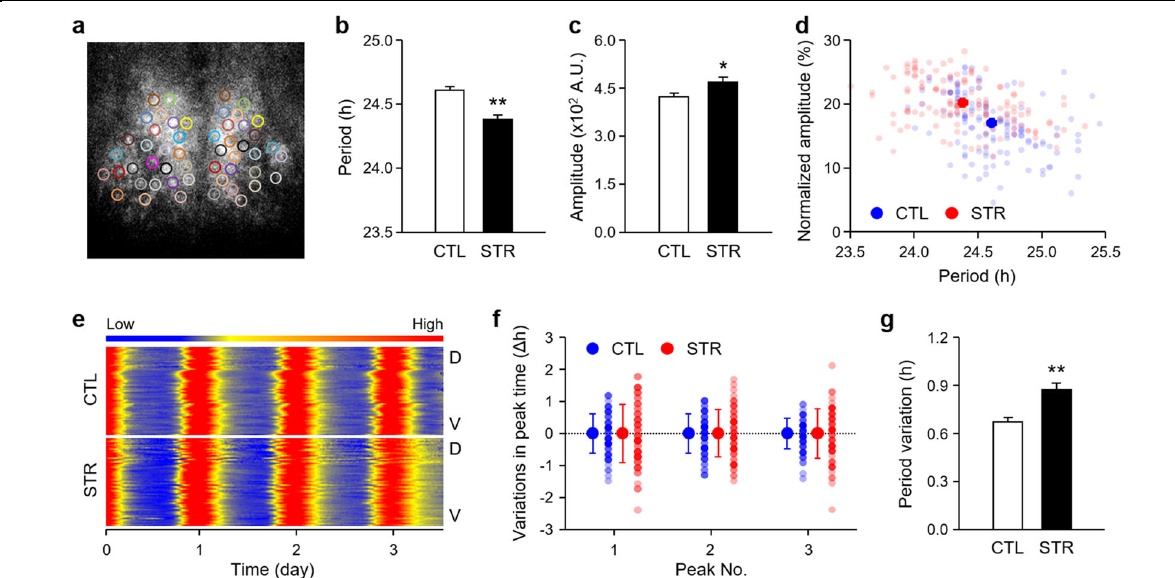
Fig. 2 Bioluminescence imaging of circadian mPer1::LUC expression at the single-cell level in the SCN cultures. a The video micrograph illustrates chosen cells from an SCN culture. b , c Effects of maternal stress on the period ( b ) and amplitude ( c ) of circadian mPer1::LUC activity at the single-cell level. The data are expressed as the mean ± SE ( n = 140 cells from two independent slices per group; ** p < 0.01 between CTL and STR by Student ’ s t -test). d Scatter plot showing the normalized amplitudes relative to the average bioluminescence signal intensity and period of mPer1::LUC expression in individual cells from SCN explants from CTL (blue) and STR (red) mice. e Raster plot presentation displaying the cellular luciferase activity measured dorsal (D) to ventral (V) throughout a given SCN slice. Red corresponds with peak bioluminescence, and blue corresponds with the trough. f Phase differences in the peak times of each cell compared with the mean value. The x-axis represents the order of peaks. The fi rst three peaks are shown here. The y-axis represents differences in the peak times of individual cells. Individual values are shown as dots. g Differences in period variations between groups are expressed as the mean ± SE ( n = 140 cells from two slices per group; ** p < 0.01 between CTL and STR, by Student ’ s t -test). The SD of peak intervals in each SCN explant was used as an index of period